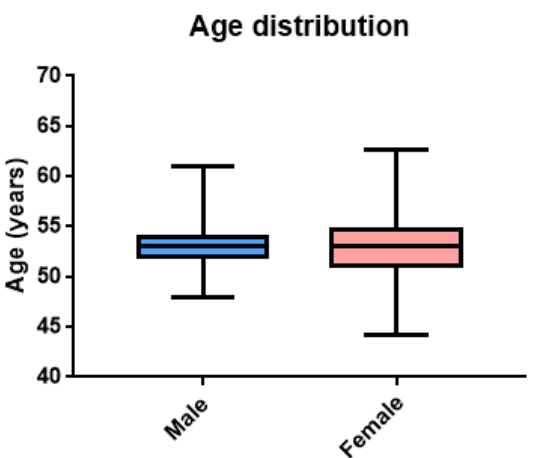
Figure 2. Age distribution of patients diagnosed with incidental cancer categorized by gender. The mean value of the age is not statistically different between the male and female groups (t = 0.661; p = 0.512).